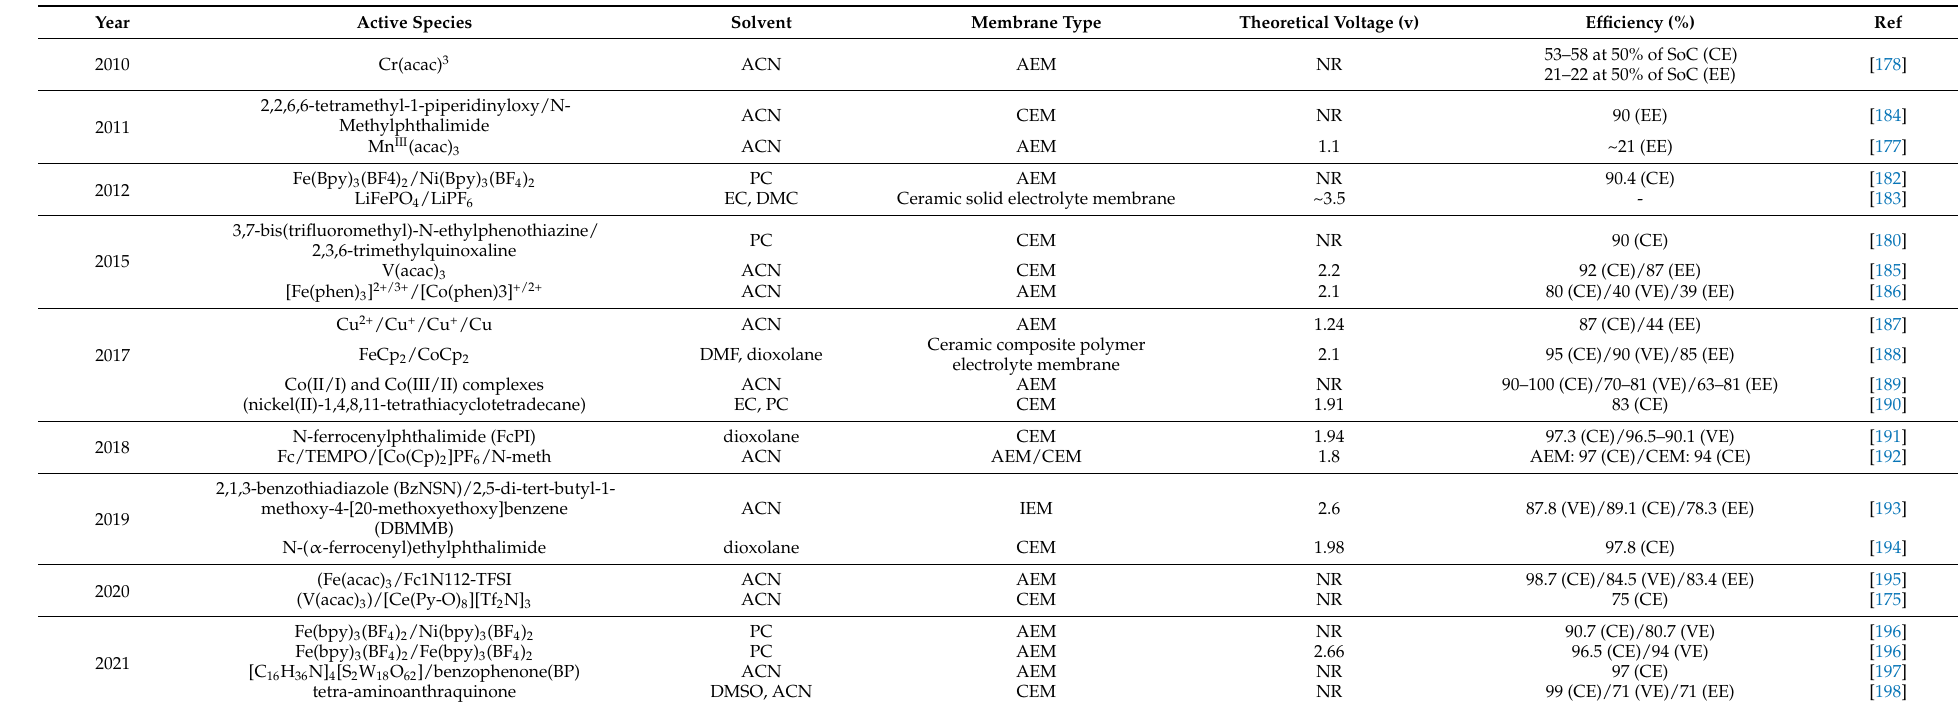
Table 5. The most relevant articles reported on NA-RFBs published since